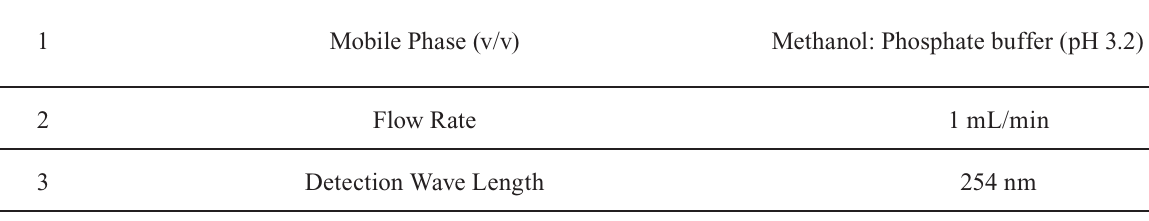
TABLE IV - Optimized Chromatographic Conditions